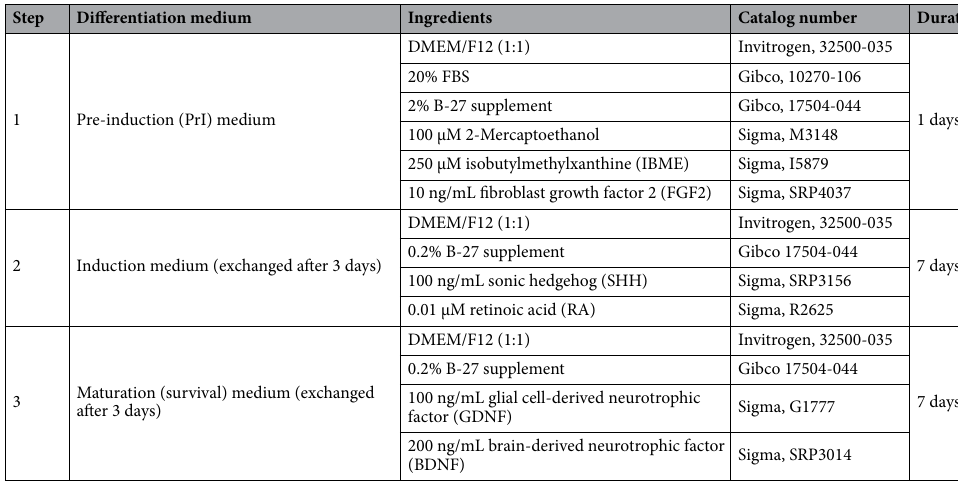
Table 3. The procedure and reagents used for differentiation of hEnSCs into motor neuron-like cells on 3D collagen hydrogels with or without EpoB-loaded PCL microspheres or cell culture plates.